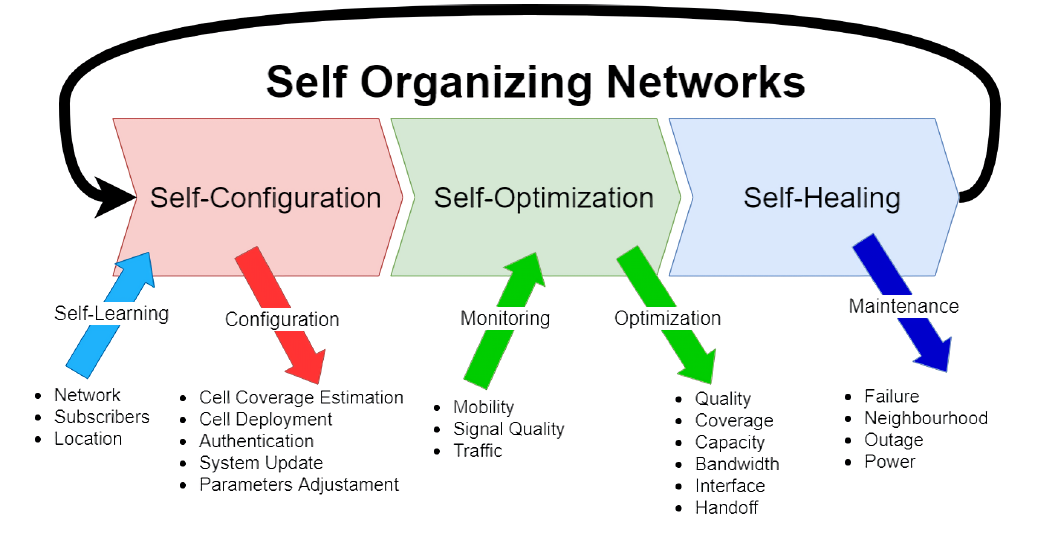
Figure 2. A self organizing network’s life